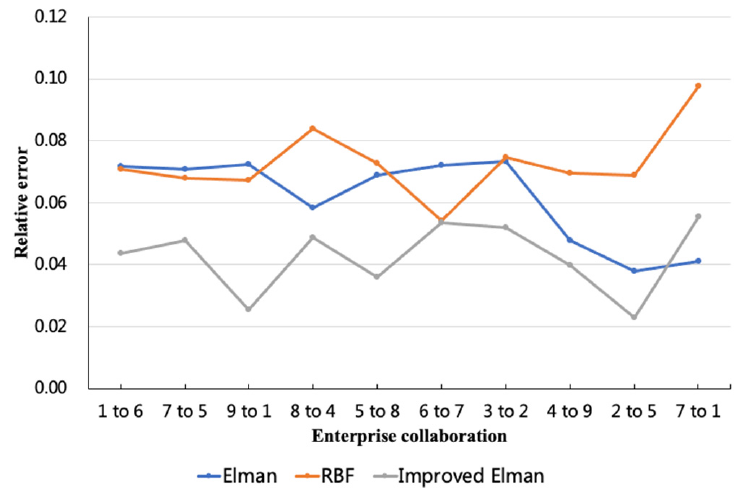
Figure 6. Relative error comparison of the proposed model with other models. Table 6. The output results and error comparison of the proposed model and other